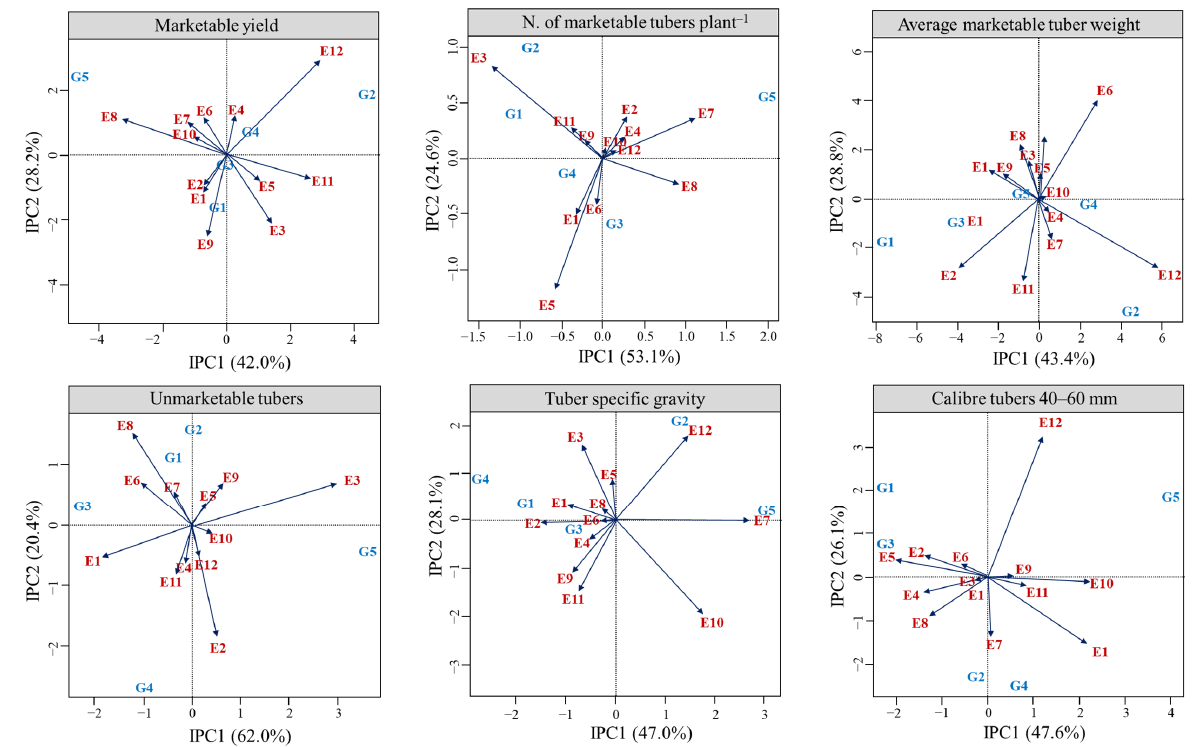
Figure 3. ‘AMMI 2’ biplot showing the first two interaction principal components (IPC1 and IPC2) effects of five potato genotypes (G) over 12 environments (E). The biplots were constructed with scaling = 0, centering = 2, and SVP = 2. G1: Arizona; G2: Generosa; G3: Levante; G4: Paradiso; G5: Vogue; E1 ‒ E4: Acireale (seasons I to IV); E5 ‒ E8: Giarre (seasons I to IV); E9 ‒ E12: Mascali (seasons I to IV).